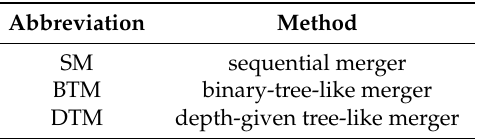
Table 6. Method comparison in experiment